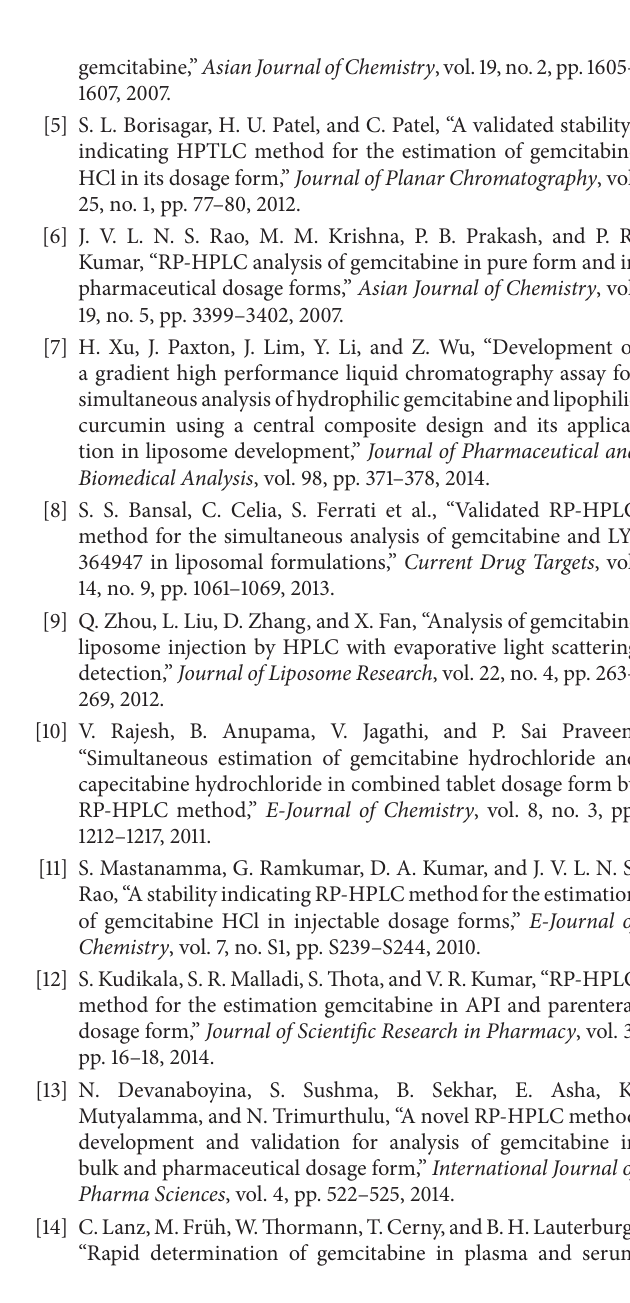
Figure 7: Typical HPLC chromatogram of gemcitabine exposed to (a) hydrolytic (H 2 O, 60 ∘ C, 1h) and (b) oxidative stress (5%, 60 ∘ C,